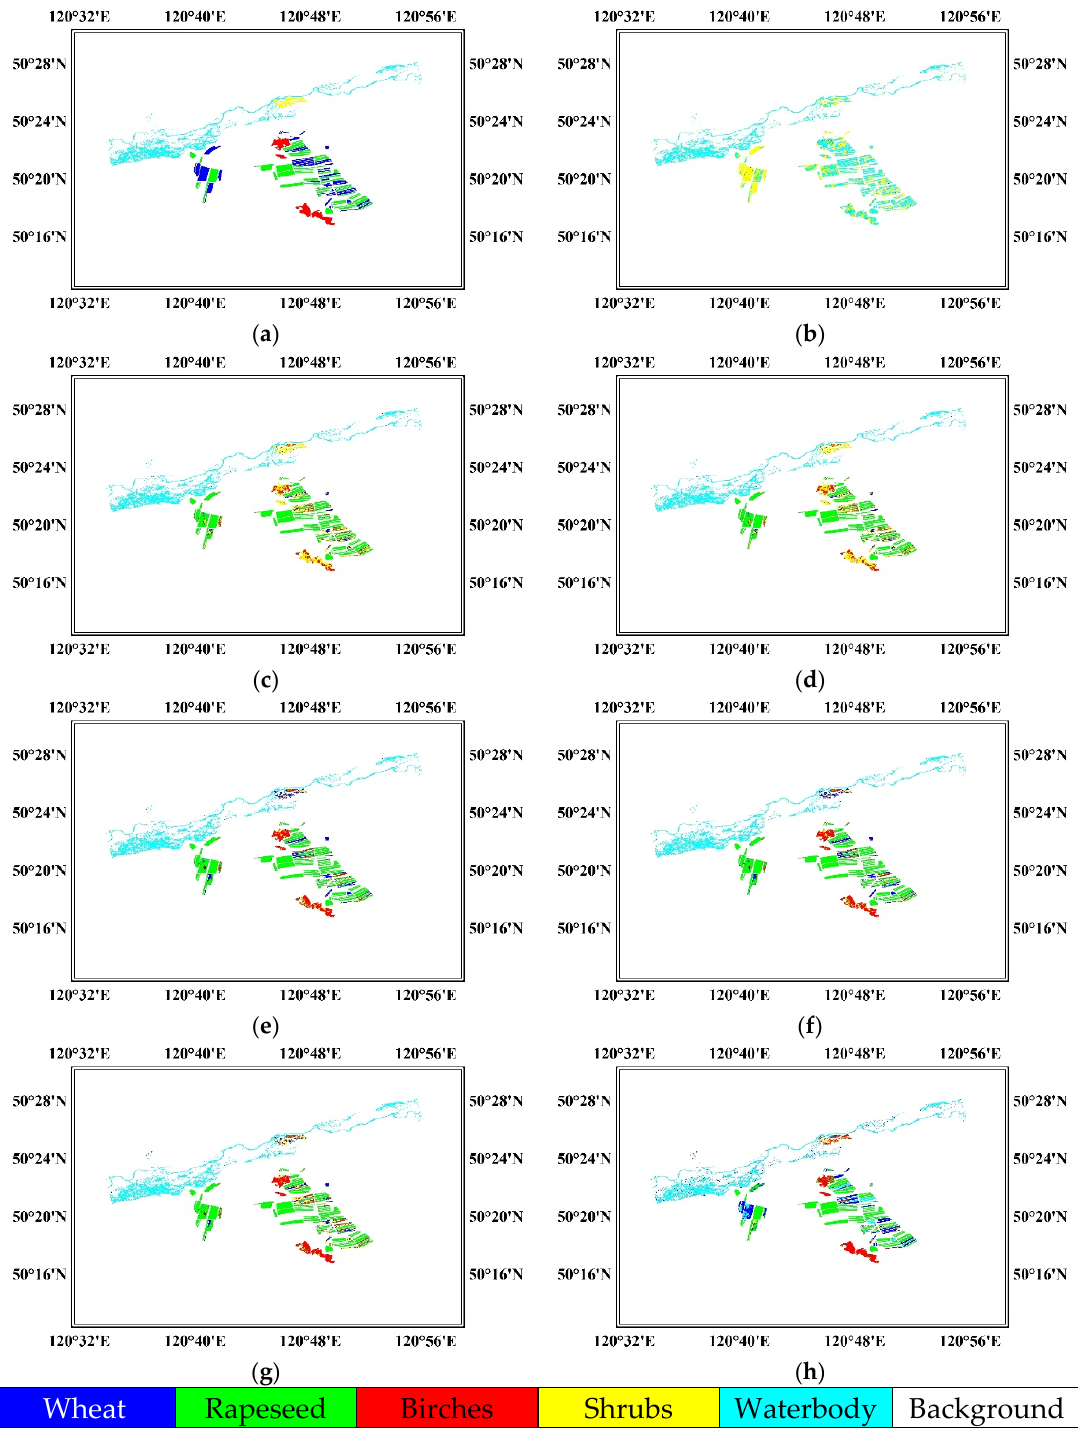
Figure 11. Ground truth map and classification maps in Erguna (SD: A -> TD: D), generated by different methods: ( a ) Ground truth; ( b ) DAC; ( c ) TCA+DAC; ( d ) SSTCA+DAC; ( e ) MIDA+DAC; ( f ) SMIDA+DAC; ( g ) SMbDA+DAC; ( h ) WSMbDA+DAC.